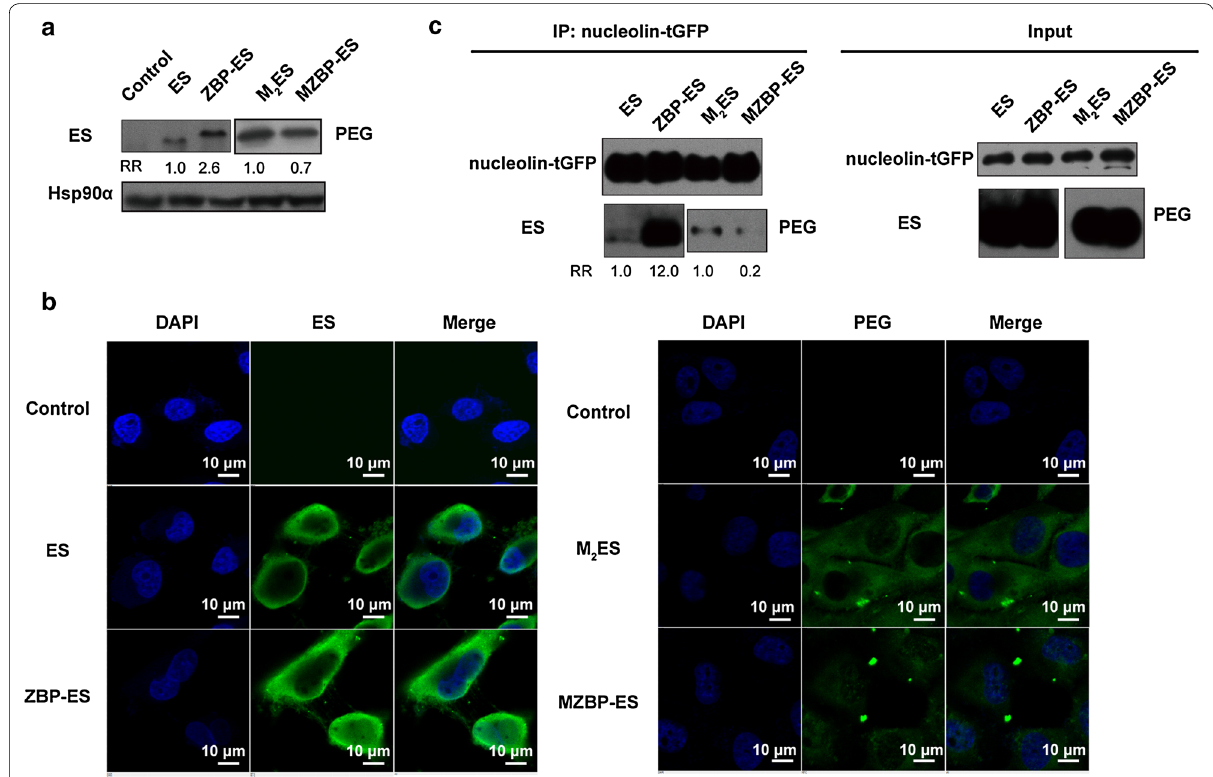
Fig. 4 Cellular uptake and interaction of ES variants with nucleolin. a ES variant internalization by endothelial cells determined by Western blotting. HMECs were treated with the indicated proteins, washed to remove cell surface-bound proteins, and used for Western blotting with anti-ES or anti-PEG antibodies to analyze the amount of internalized proteins. Heat shock protein 90α (Hsp90α) was used as the loading control. b Internaliza- tion of ES variants into endothelial cells detected by immunofluorescence. DAPI, 4 ′ ,6-diamidino-2-phenylindole. c Interaction of ES variants with nucleolin-turbo green fluorescent protein (nucleolin- tGFP ) in vitro. Nucleolin-tGFP proteins were expressed in endothelial cells, and immunopre- cipitated with anti-tGFP antibody and Protein G beads. The purified nucleolin-tGFP beads were incubated with 0.5 μg indicated ES variant at 4 °C for 1 h. Then, the beads were washed and collected, and Western blotting was used to detect the amount of bead-bound proteins. RR , relative